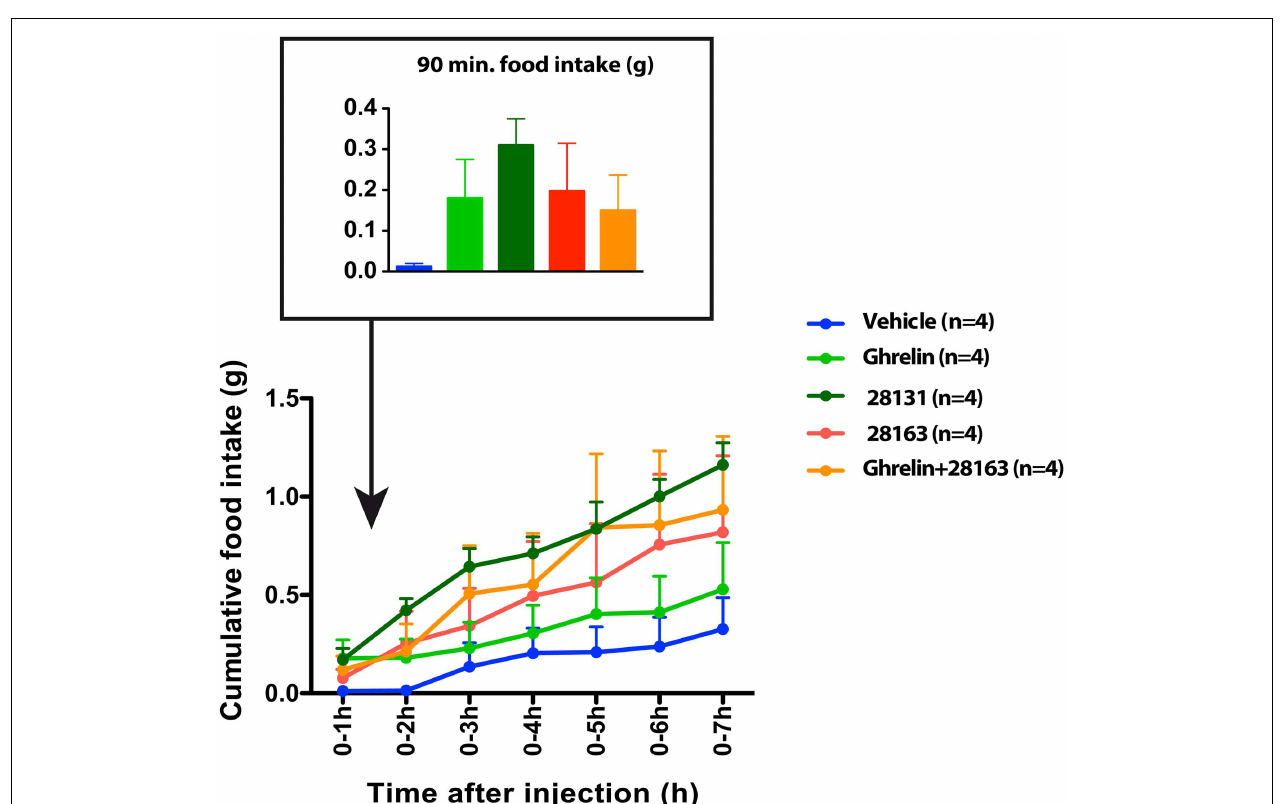
co-administered with BIM-28163 (150nmol). Data represent mean ± SEM. Repeated measures ANOVA over time (7h) and across treatments shows an interaction between time and treatment on cumulative food intake. P = 0.06 BIM-28131 vs. vehicle, Fisher PLSD post-hoc test.